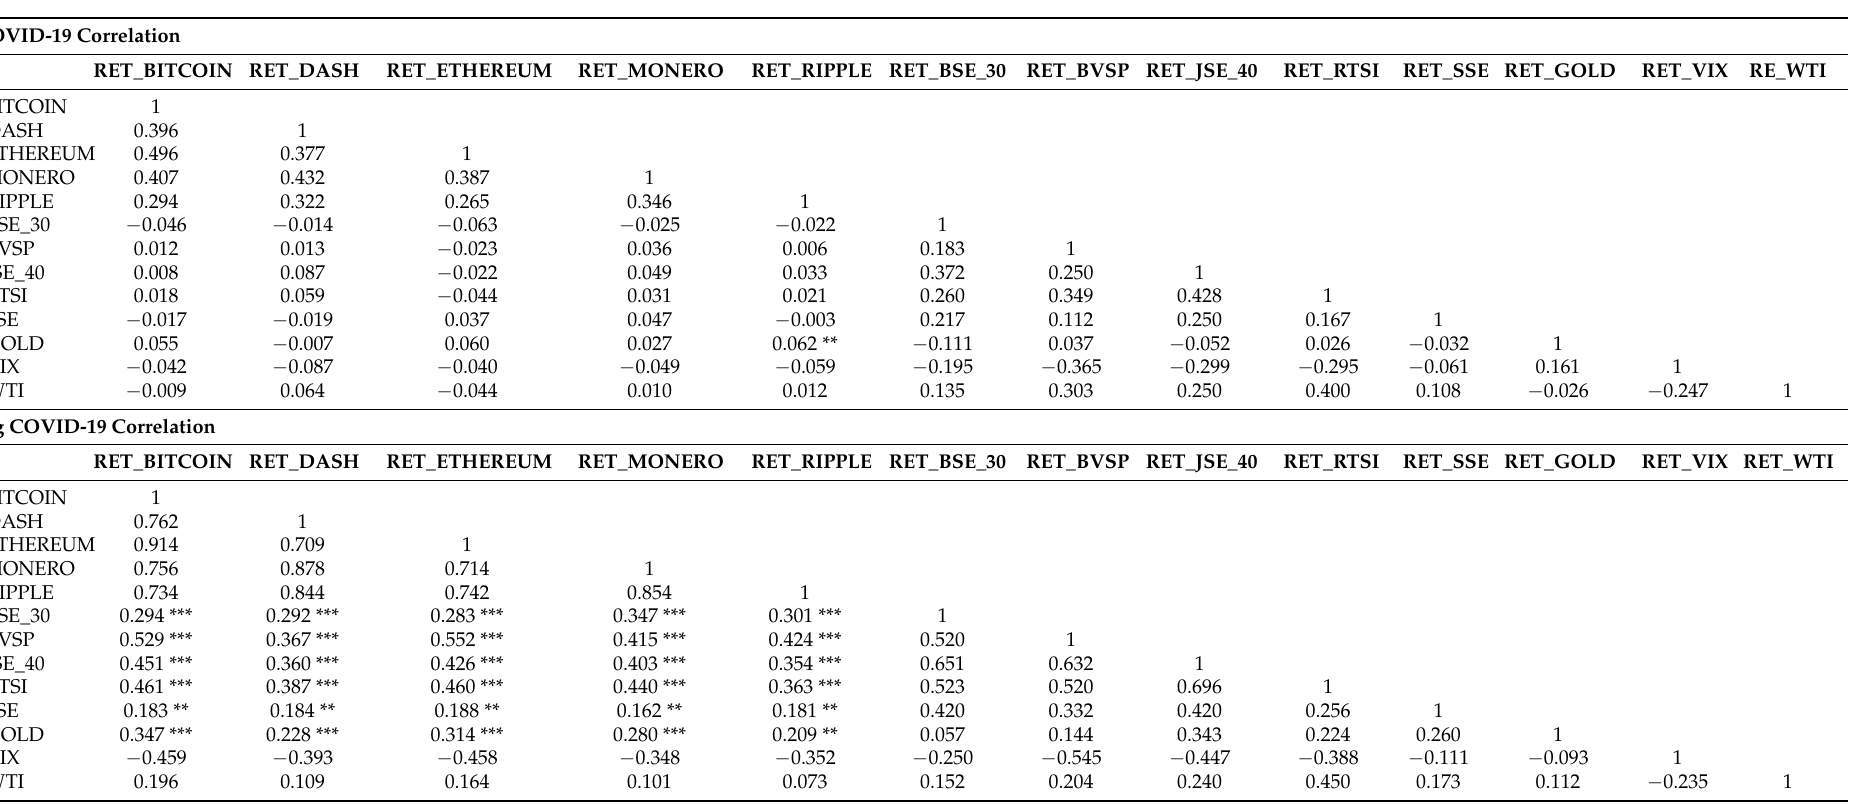
Table 2. Correlation dynamics between five crypto assets and BRICS stock indices, gold, VIX, and WTI in pre- and during the COVID-19 crisis period. Pre-COVID-19 Correlation